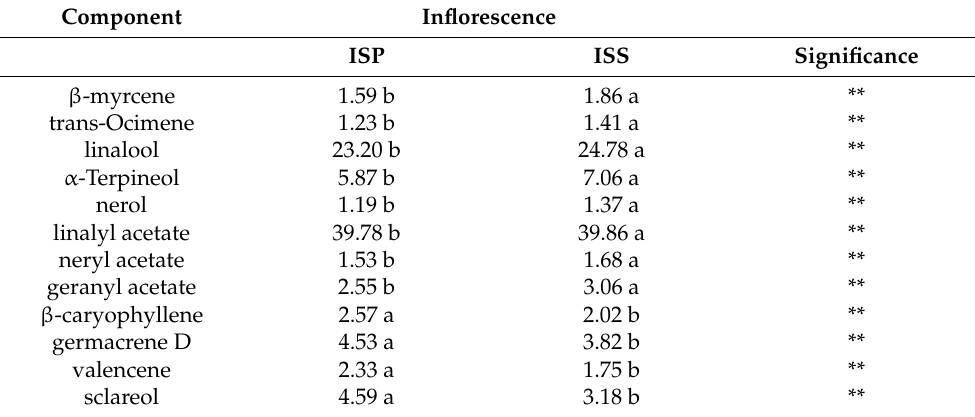
Table 6. Effect of inflorescence type (TIPS) on the composition of the essential oil principal